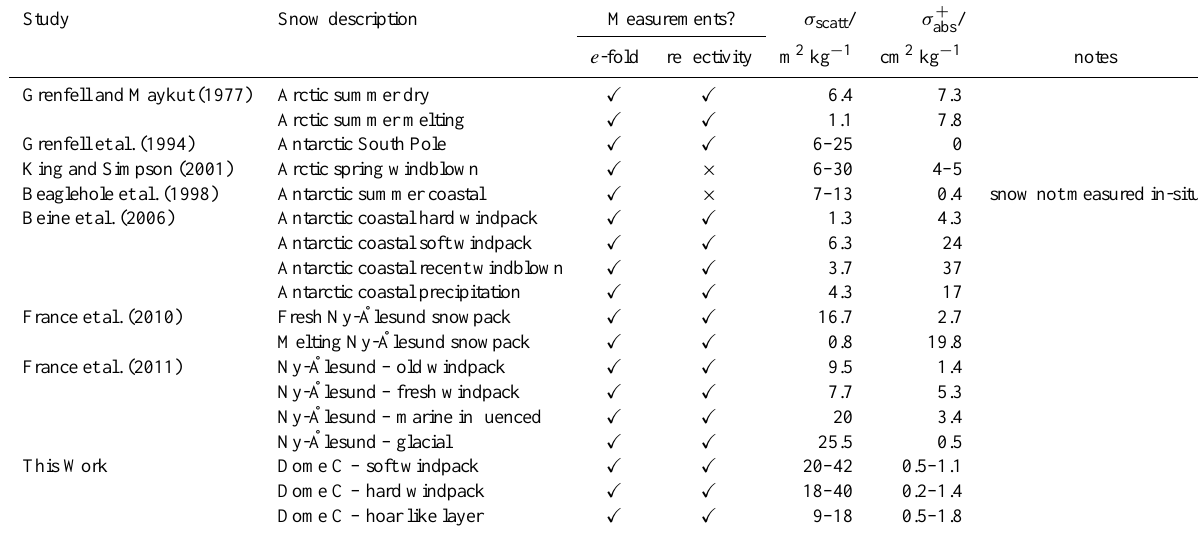
Table 2. Comparison of optical coefficients for Dome C snow layers with previously investigated sites, all optical coefficient measurements are for a wavelength of 400 nm.